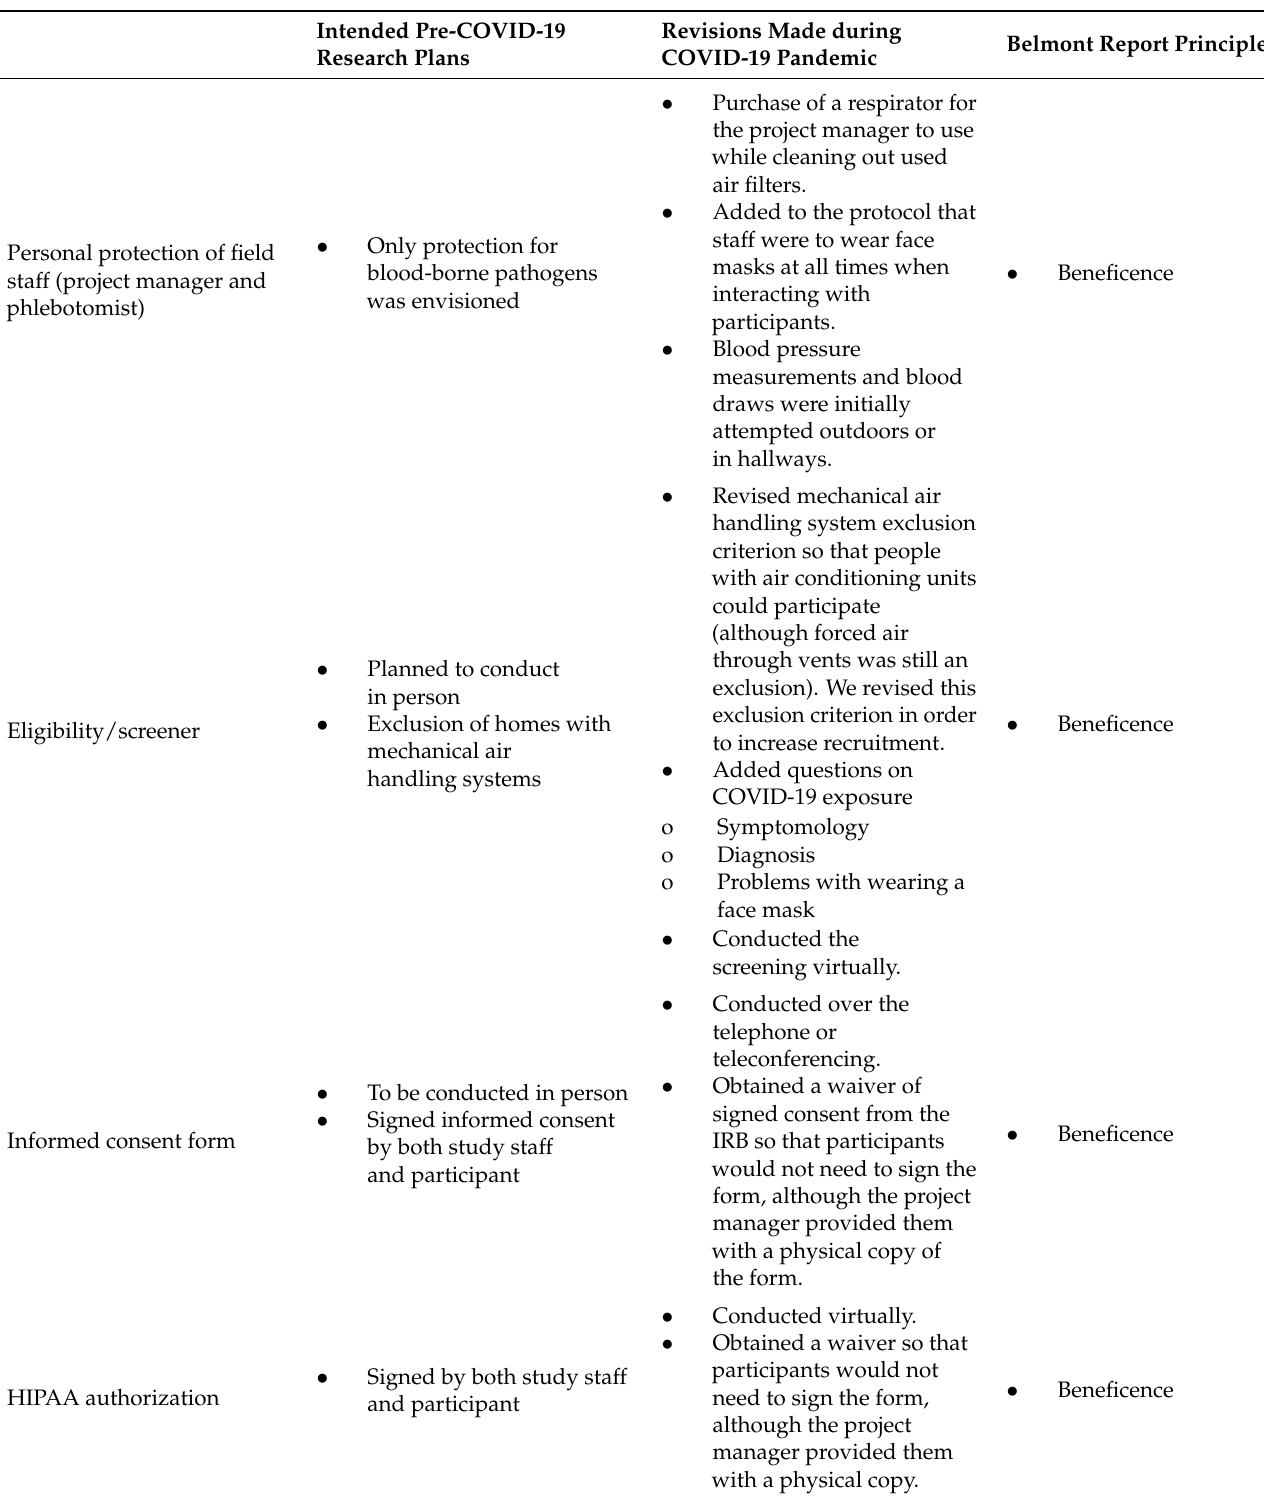
Table 2. Changes made to HAFTRAP after the COVID-19 restrictions in March